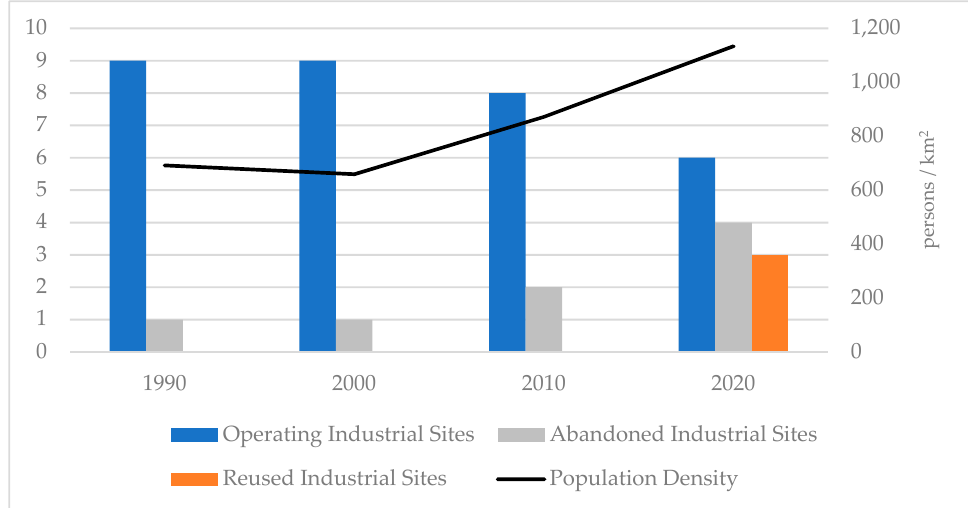
Figure 28. The change in the relationship between the operation state of resource-intensive industries and the population density over time (Figure source: own drawing; data from: [84]).